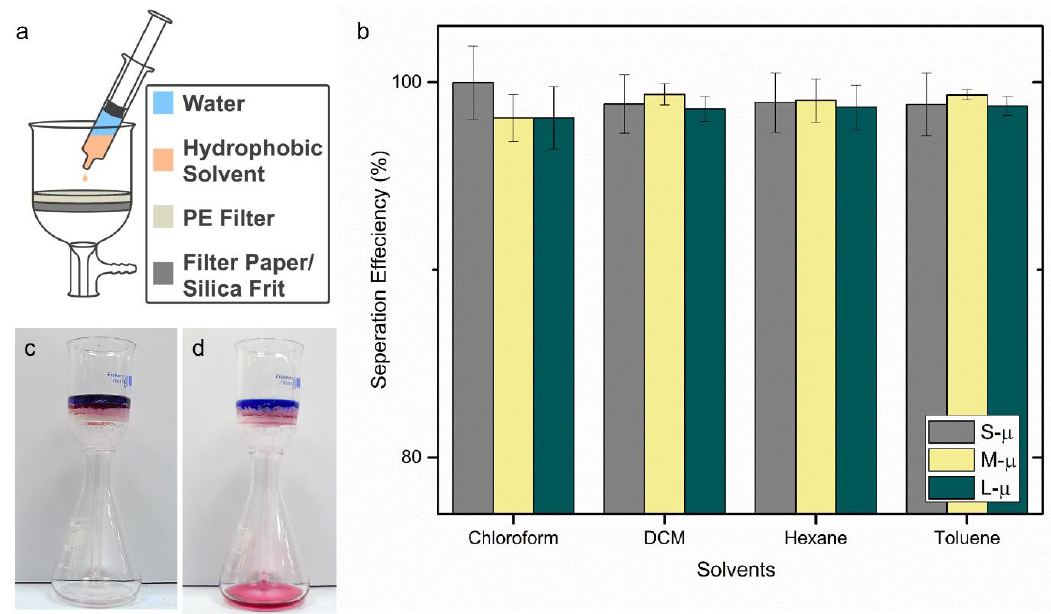
Figure 6. ( a ) The separation efficiency measurement setup. ( b ) The separation efficiency results for different water/oil mixtures with filters made using different PE powder sizes. ( c , d ) The chloroform/water mixture before ( c ) and after ( d ) separation using an S-µ PE filter.